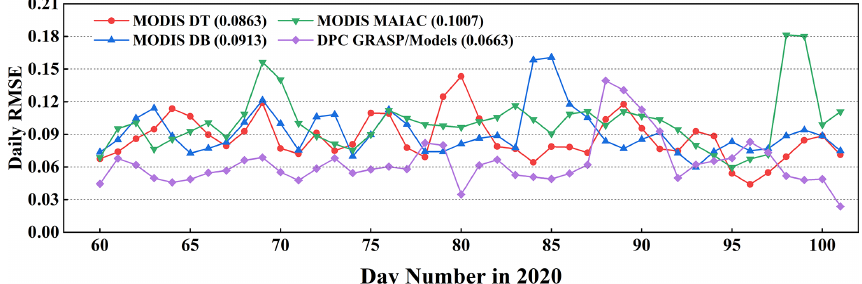
Figure 8. Time series of daily RMSE for the selected AERONET stations during March and April of 2020. The numbers in brackets are averaged values of daily RMSE. The positions of AERONET stations are the same with Fig. 5.